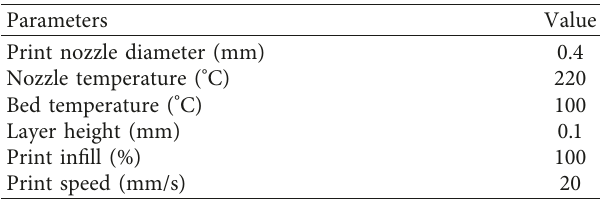
Figure 1: Melt extrusion process setup for ABS/GO composite filament fabrication. Table 1: Parameters used for the FFF 3D printing of ABS and ABS/GO